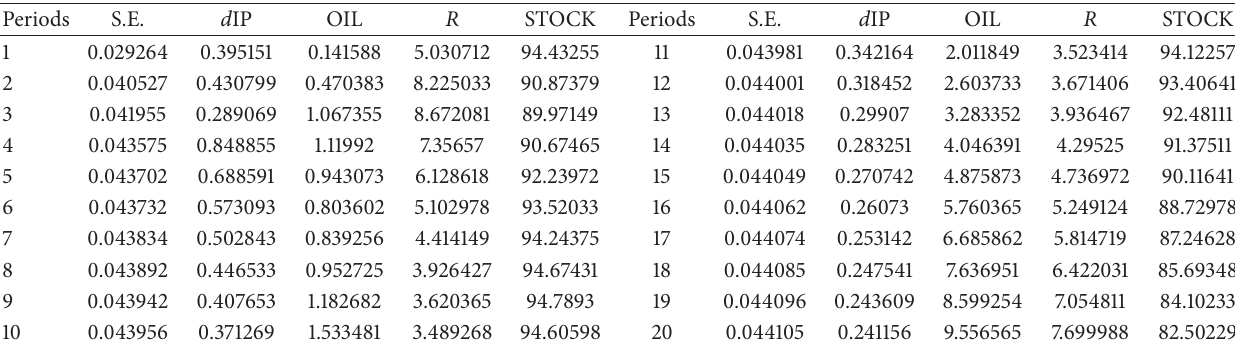
Table 5: Generalized variance decomposition of STOCK.